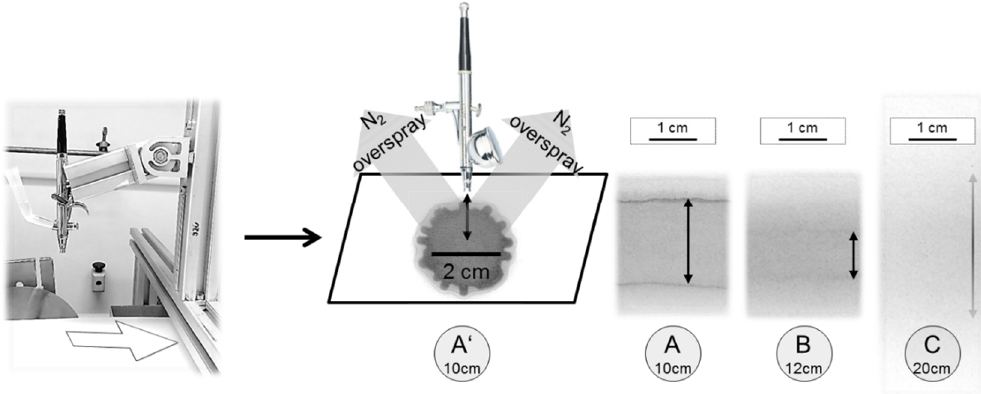
Figure 4. Airbrush pistol fixed on an aluminium profile rack (Rose + Krieger GmbH) with self-build tank. Solvent was 1,4-dioxane with small amounts of black ink added to the solution. ( A’ ) illustrates sample sizes with conditions similar to previous works (~3 cm 2 ) [23]; distance d from nozzle to support was 10 cm, pressure p was 1.5 bar. In ( A – C ) we started moving the support with 8 mm / s slightly raising the distance. ( A ) with d = 10 cm shows a dense homogeneous film of ~2 cm, ( B ) with d = 12 cm the width of the dense homogenous part falls to ~1 cm and ( C ) with d = 20 cm it was not possible to get a dense film because of too quick solvent evaporation.